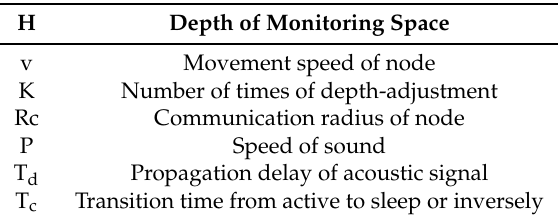
Table 1. Symbolic description of complexity